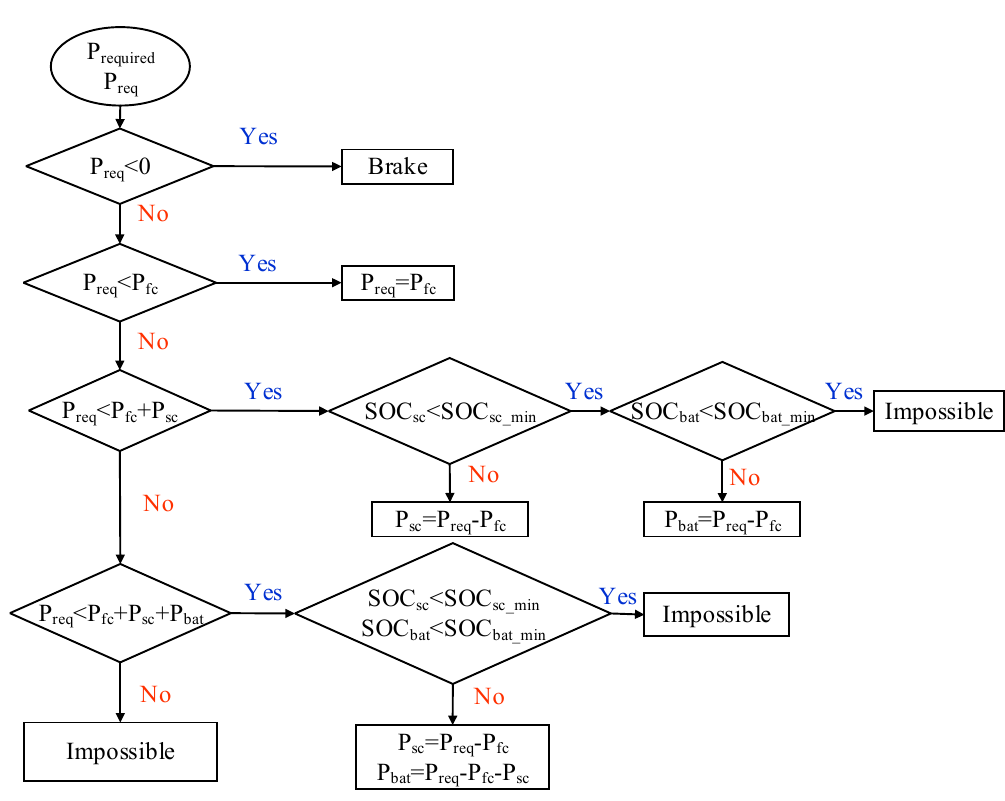
Figure 3. The flowchart of the power systems [16,17,19].